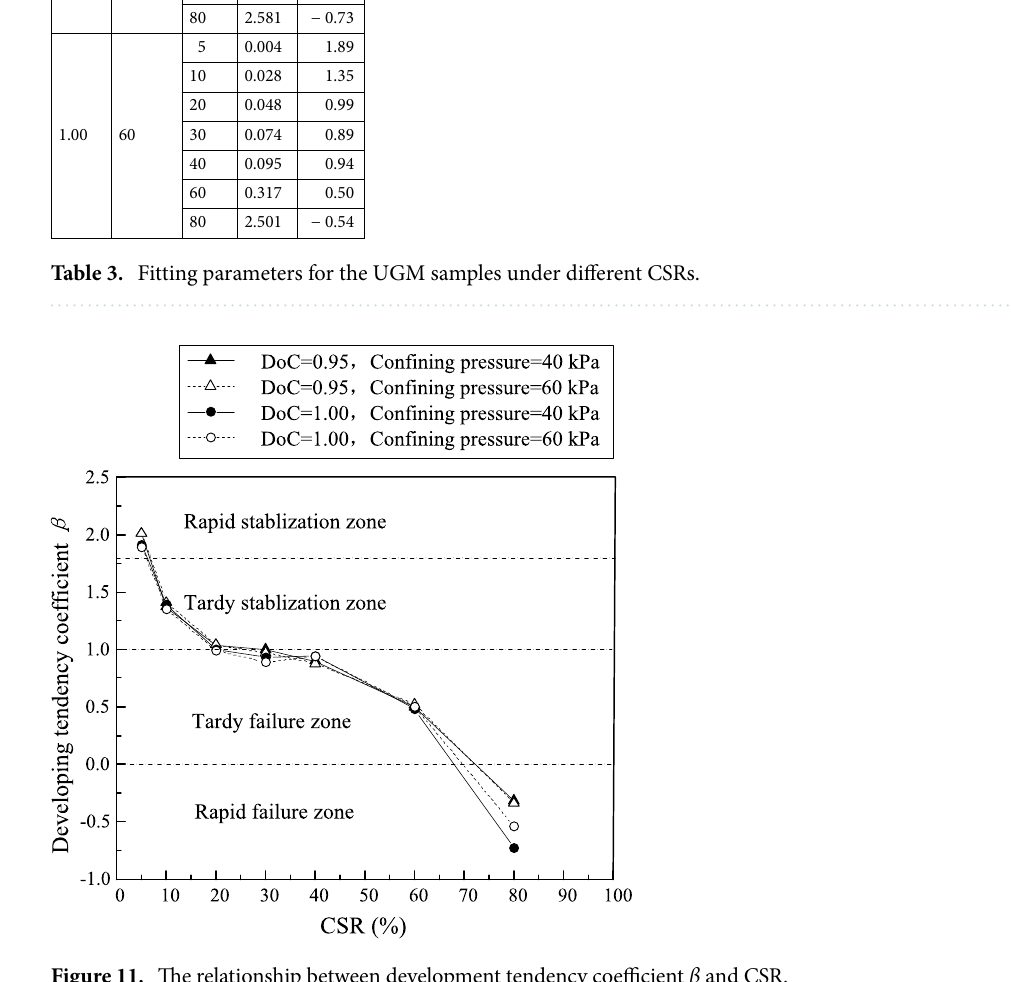
Figure 11. The relationship between development tendency coefficient β and